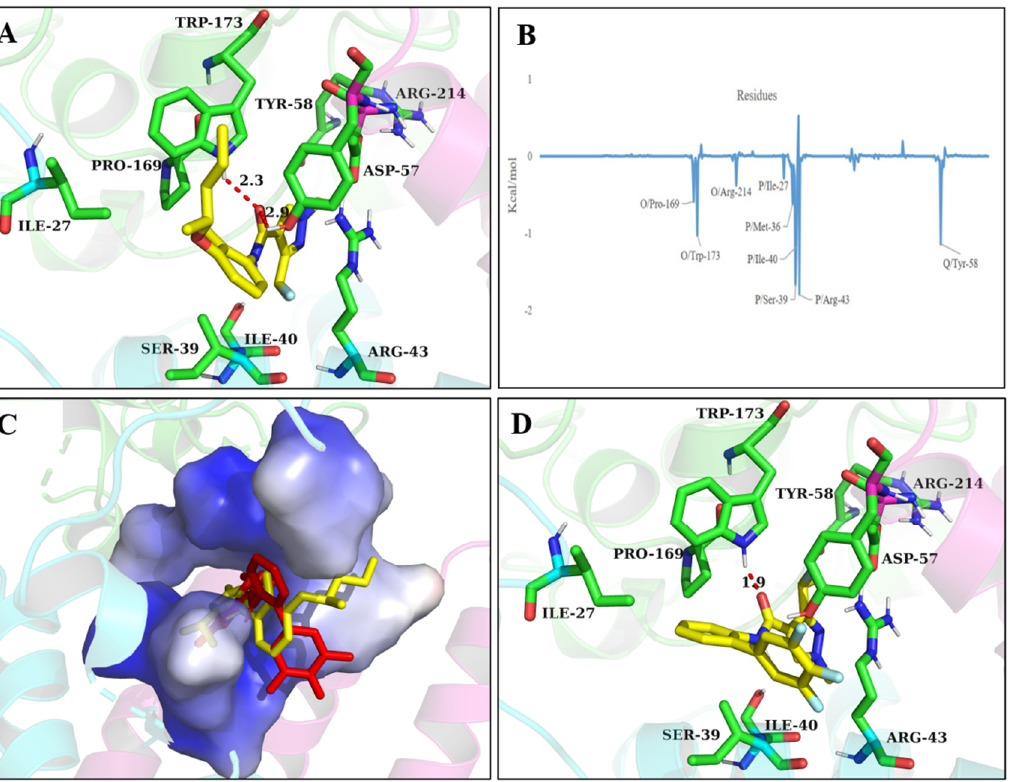
Figure 7. The docking binding mode of SYP-32497 and fluxapyroxad with succinate dehydrogenase (PDB code: 2FBW): ( A ) The binding pattern of compound SYP-32497 to SDH; ( B ) Free energy decomposition of SYP-32497 combined with SDH; ( C ) Composite diagram of SYP-32497 and the combination mode of fluxapyroxad and SDH; ( D ) The binding pattern of fluxapyroxad and SDH. Table 2. The binding free energy of SYP-32497 and fluxapyroxad with SDH. Fungicides